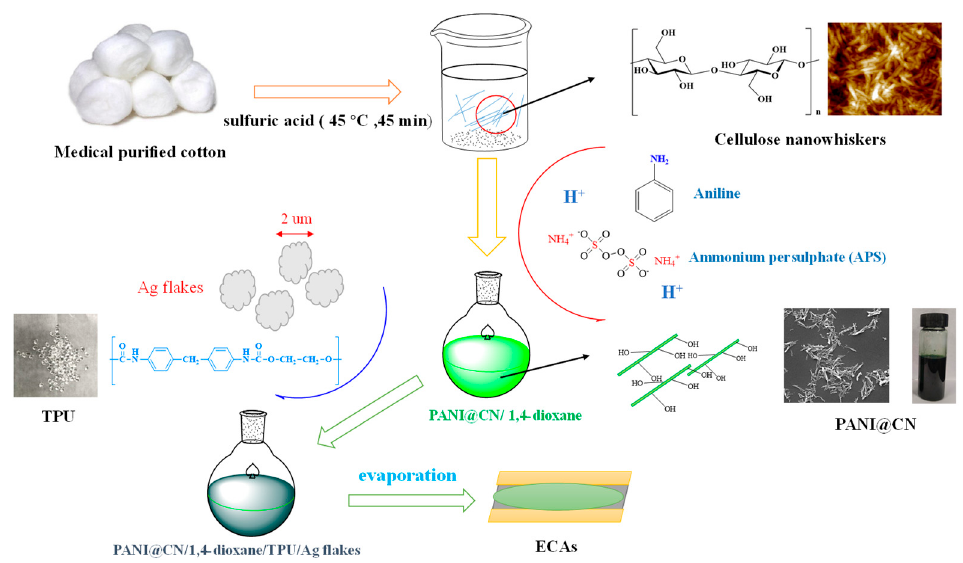
Figure 1. Schematic illustration of the preparation of polyaniline@cellulose (PANI@CNs)/silver-PU- electrically conducted adhesives (ECAs).